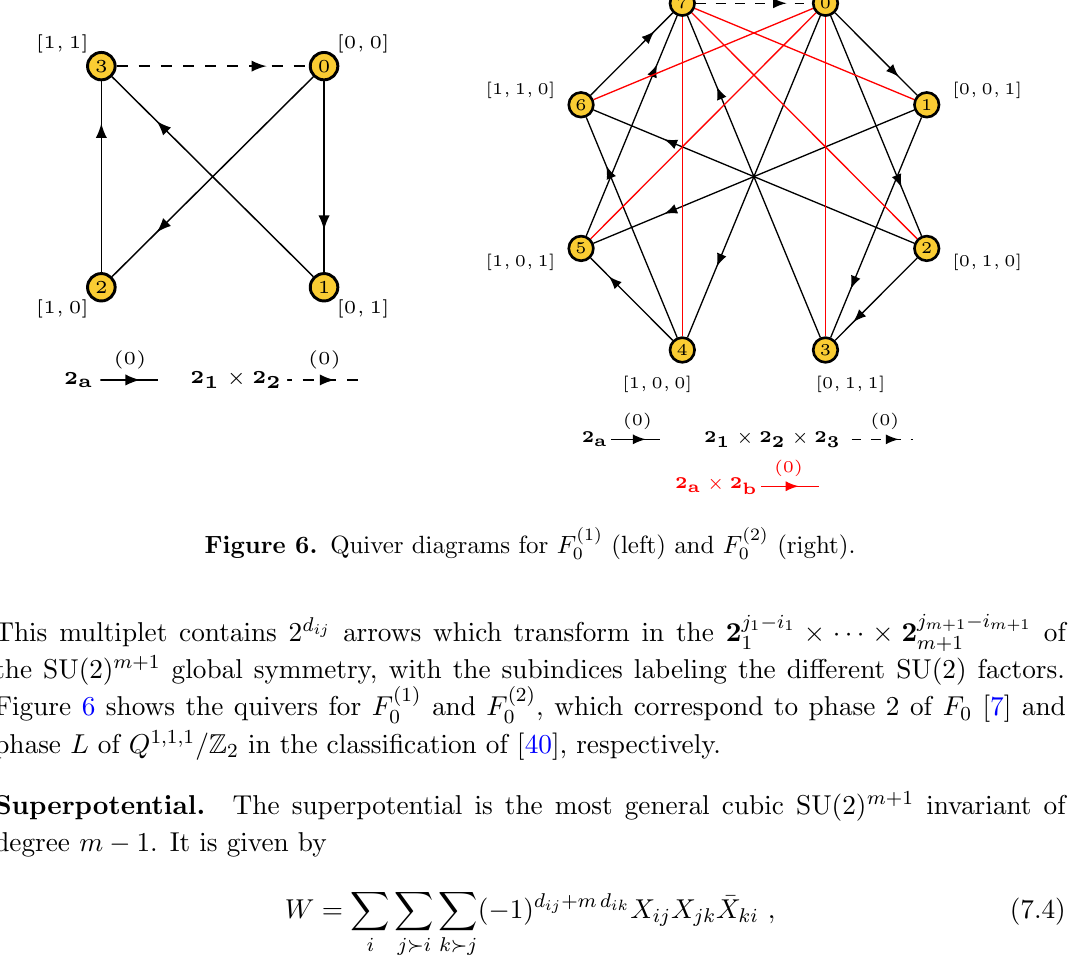
(left) and F (2) 0 0